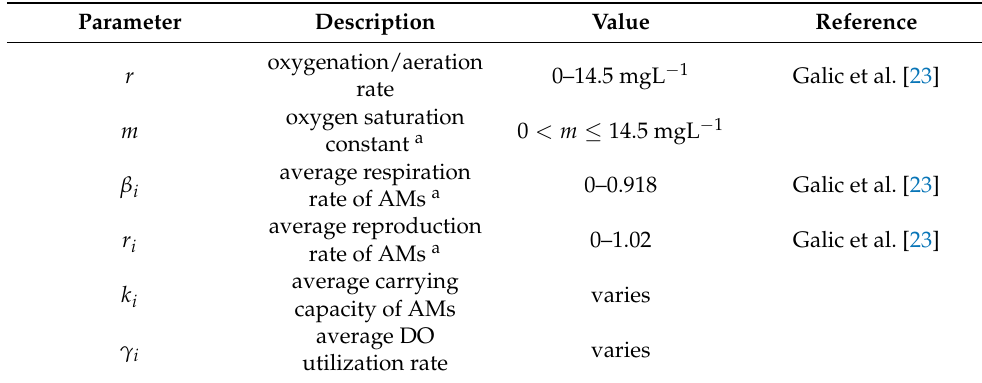
Table 1. Description and parameter values of system